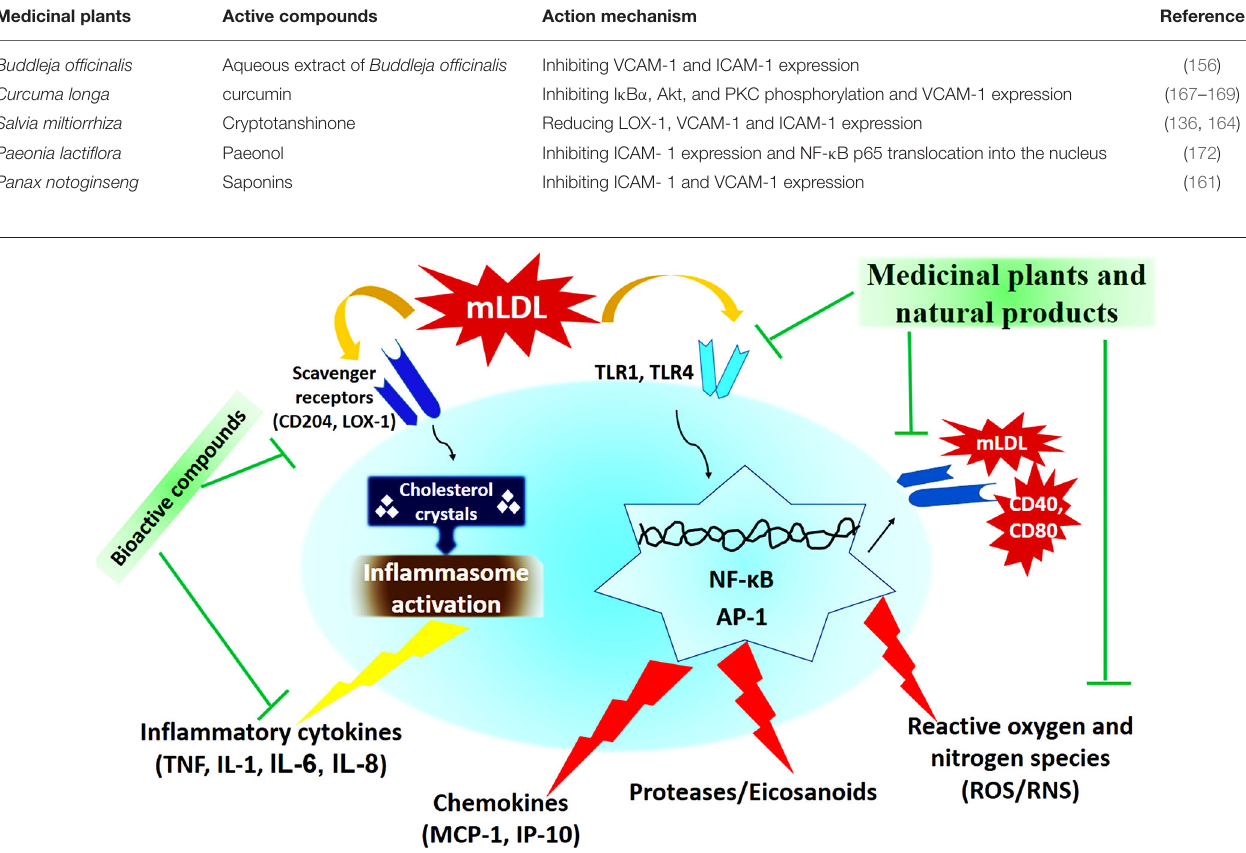
extract of Astragalus membranaceus decreased blood glucose and triglyceride (TG) via the increasing activity of PPAR- α and PPAR- γ (146). Also, downregulation of CD40 ligand and C- X-C chemokine receptor type 4 (CXCR4) expression on the platelet surface, and stromal cell-derived factor-1 (SDF-1) and CXCR4 expression in the aorta are the most important effects of A. membranaceus and Astragaloside IV (147). β -Elemene isolated from Curcuma wenyujin inhibits the production of pro-inflammatory cytokines and cell adhesion molecules such as IL-1 β , TNF- α , INF- γ , MCP-1, and ICAM-1 and decreases the size of atherosclerotic lesions (152). Tripterygium wilfordii and its triterpenoid, Celastrol, prevent phosphorylation and degradation of I κ B. This medicinal plant reduces the production of inducible nitric oxide synthase (iNOS), NO, and pro- inflammatory cytokines such as TNF- α and IL-6 (153). Curcuma longa and curcumin inhibit SR-A-mediated oxidized LDL uptake and lead to reduced cholesterol accumulation in the arterial wall via activation of the AMPK-SIRT1- LXRa signaling pathway (167, 168). Also, curcumin shows anti-inflammatory properties via inhibiting the activity of iNOS, COX-2, lipoxygenase, and xanthine oxidase, and activating NF-kB (169). C. longa